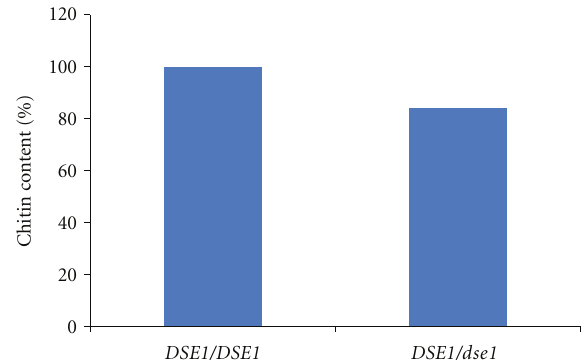
Figure 3: Biofilm formation on polystyrene surfaces. Strains were plated on polystyrene microtiter plates and incubated for 24 h followed by rinsing and methanol addition to allow the fixation of biofilm-forming cells. Afterward, crystal violet was added to stain the newly formed biofilm cells. Unbound crystal violet was washed away and bound crystal violet was released by adding acetic acid to the wells. OD at 600nm of the released crystal violet was read, and it proportionally corresponded to the amount of biofilm forming cells present in the wells. The negative control lacked any C. albicans cells but was treated similarly. Note the significant defect in biofilm formation in the mutant strain ( P = . 002).